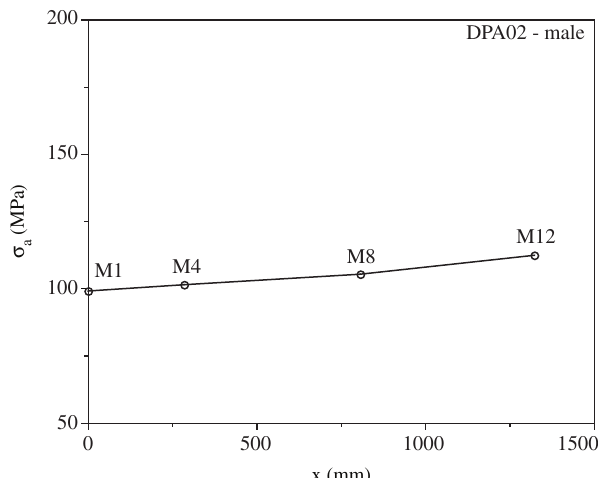
Figure 6. Typical set of data from a preliminary load test for DPA02 (box section).